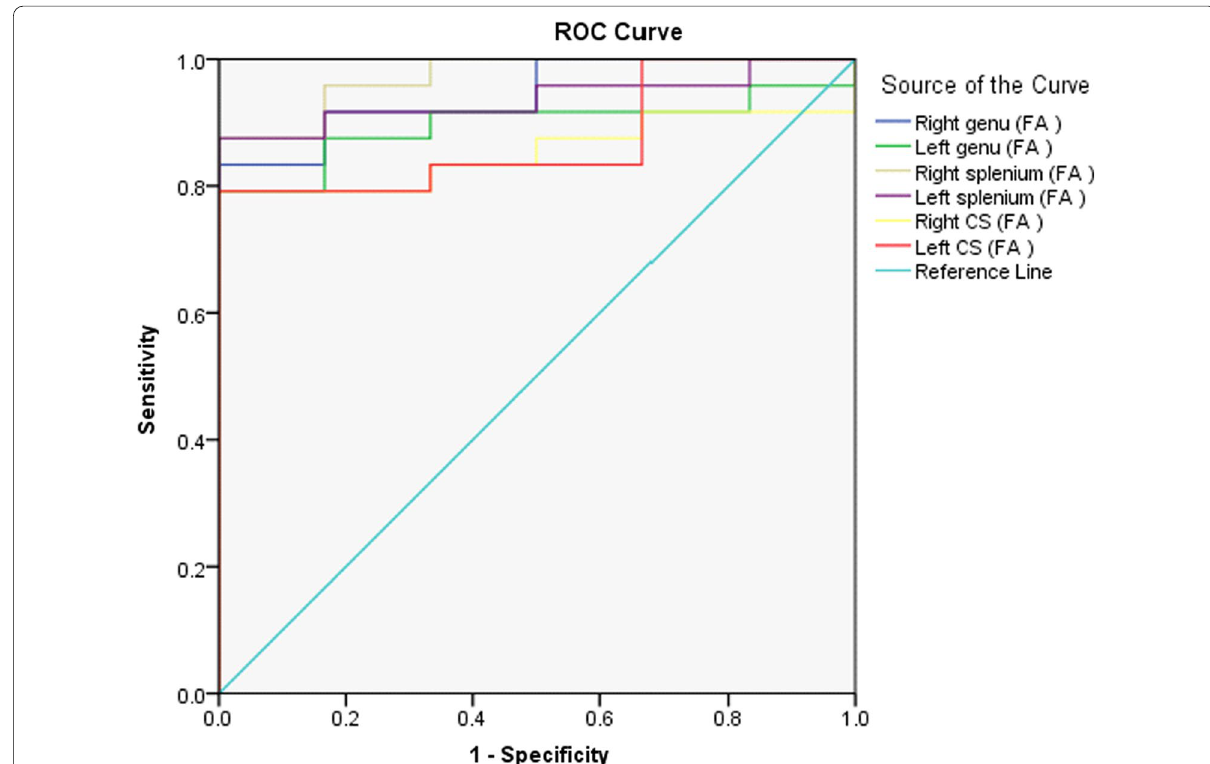
Fig. 2 ROC curve demonstrating specificity and sensitivity of FA in genue, splenium and CS tract on both sides